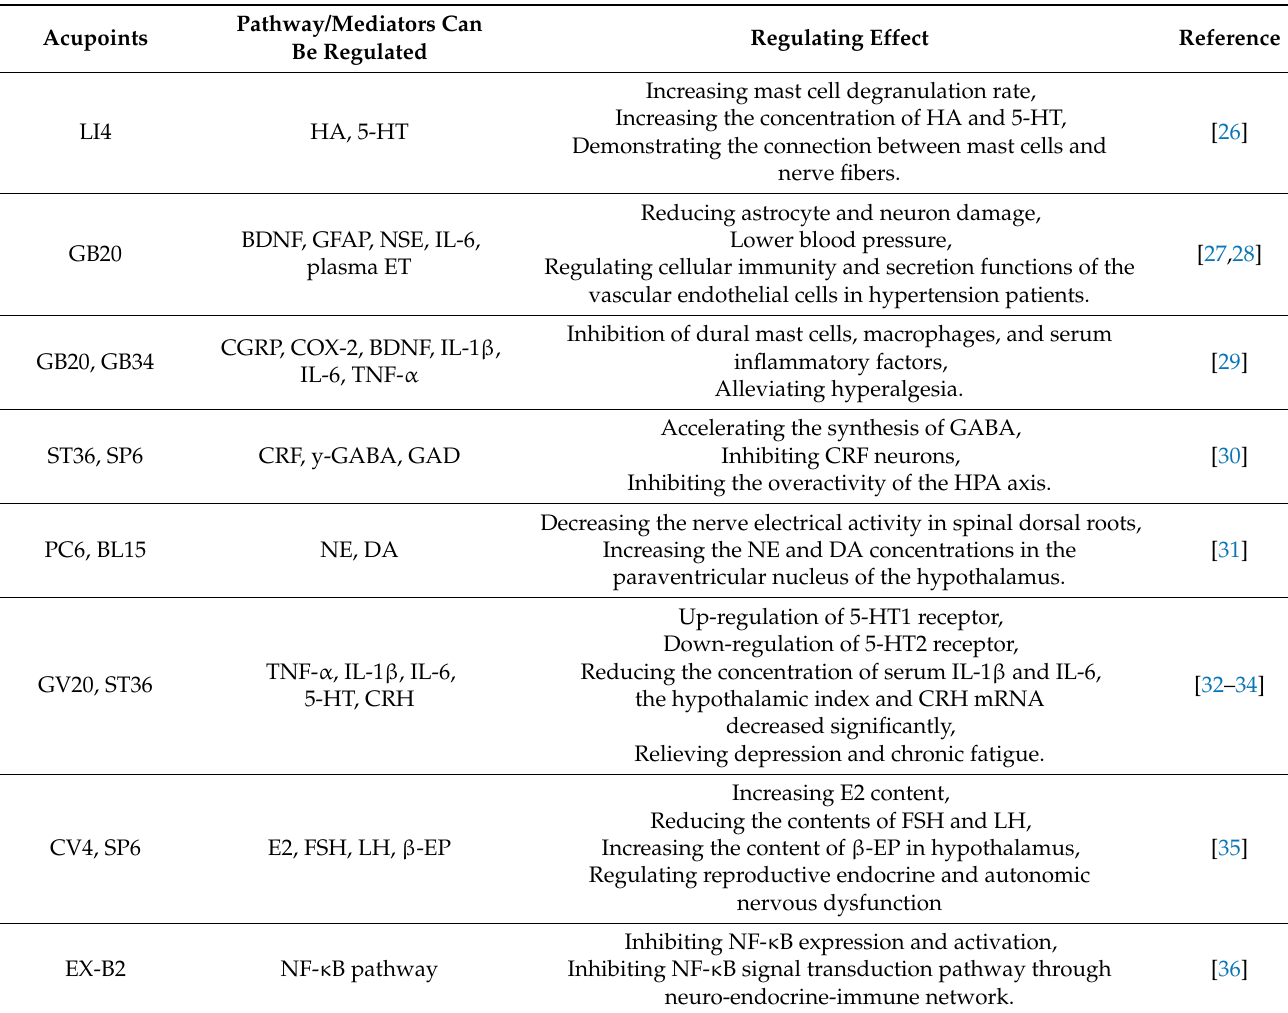
Table 1. Examples of acupoints and its effects of regulating neuro-endocrine-immune